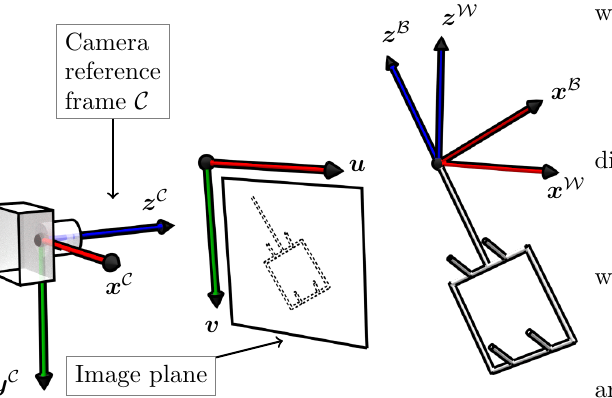
is rotating rela- B . The W